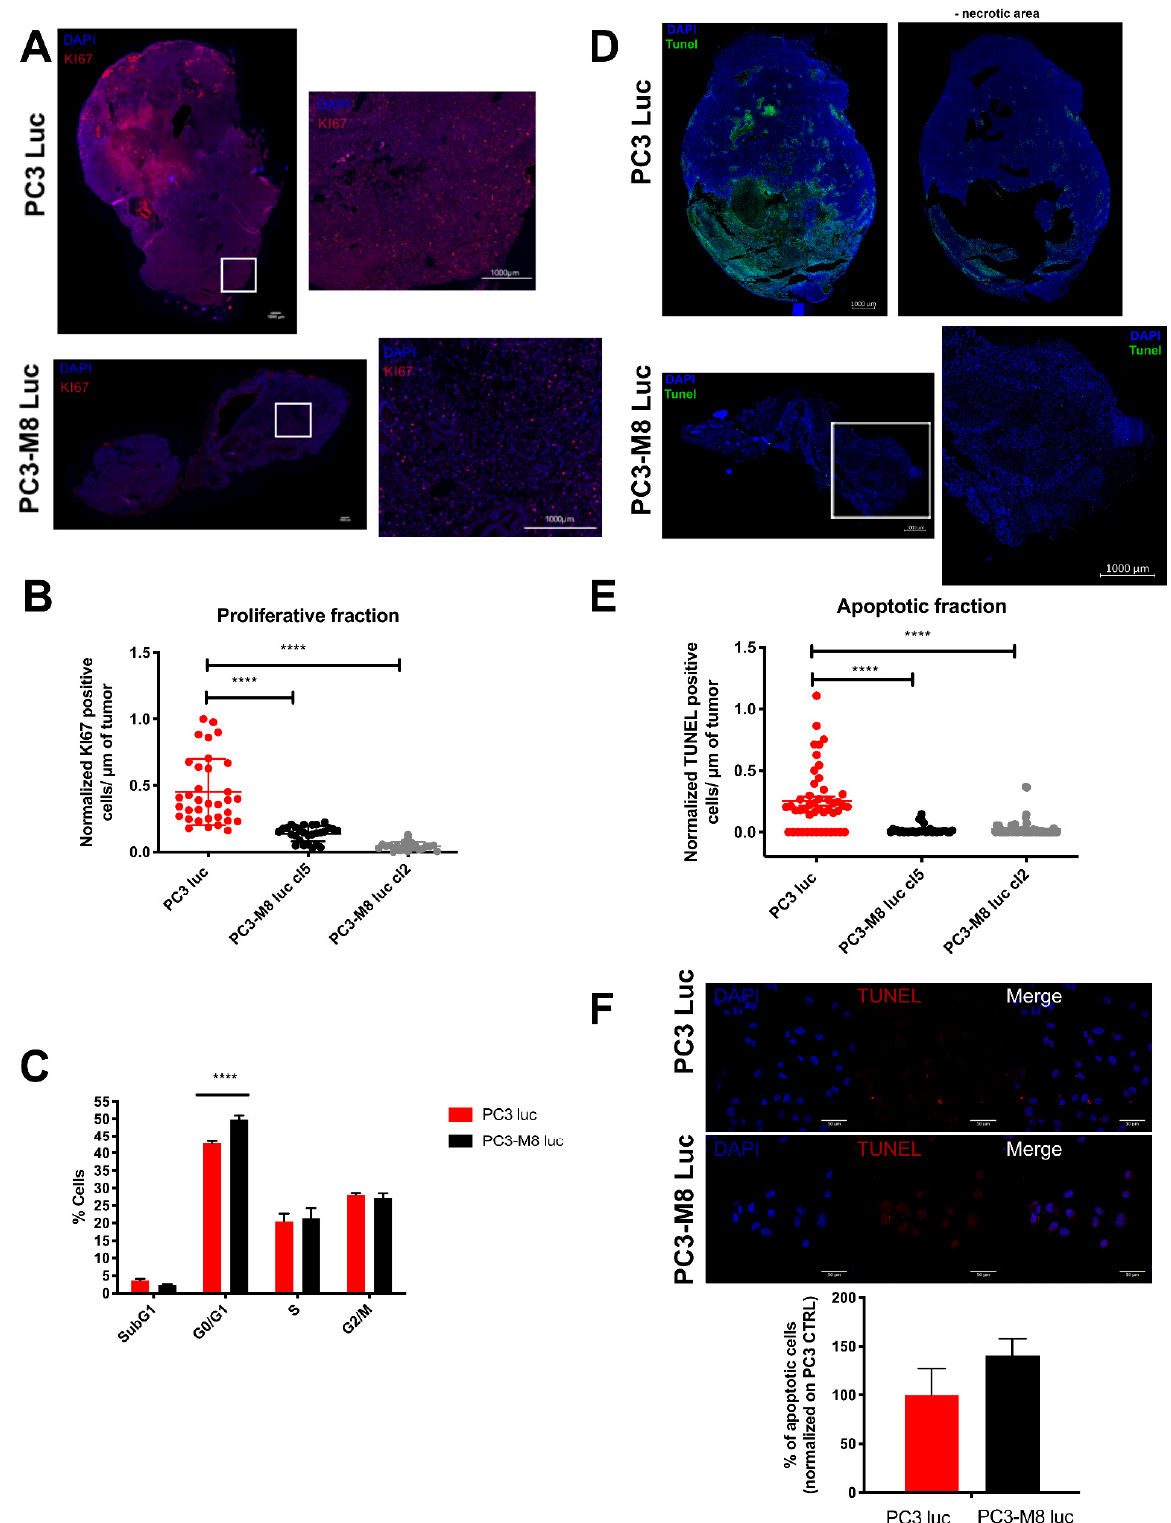
Figure 2. TRPM8 overexpression affects cell proliferation but not apoptosis. ( A ) Representative images of Ki67 staining in prostate tumors from PC3 luc and PC3–M8 luc orthotopic grafts. ( B ) Quan- tification of Ki67 staining of tumors from PC3 luc and PC3–M8 luc grafts. Data are expressed as Ki67 positive cells/ µ m (n = 34 for PC3 luc (red dots); n = 28 for PC3–M8 luc cl5 (black dots); and n = 21 for PC3–M8 luc cl2 (grey dots); statistical significance: **** = p <0.0001, ordinary one–way ANOVA